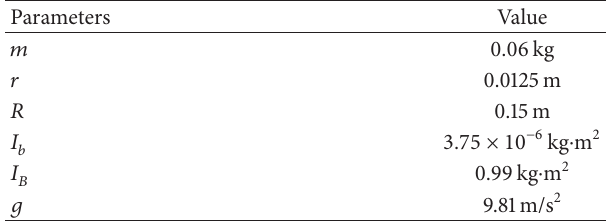
Table 3: BOS system parameters.